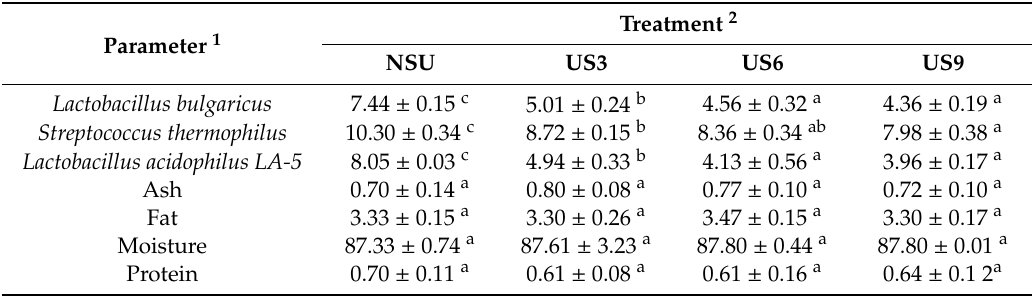
Table 1. Microbial counts and chemical composition in goat milk yogurts were measured on the first day of storage at 4 ◦